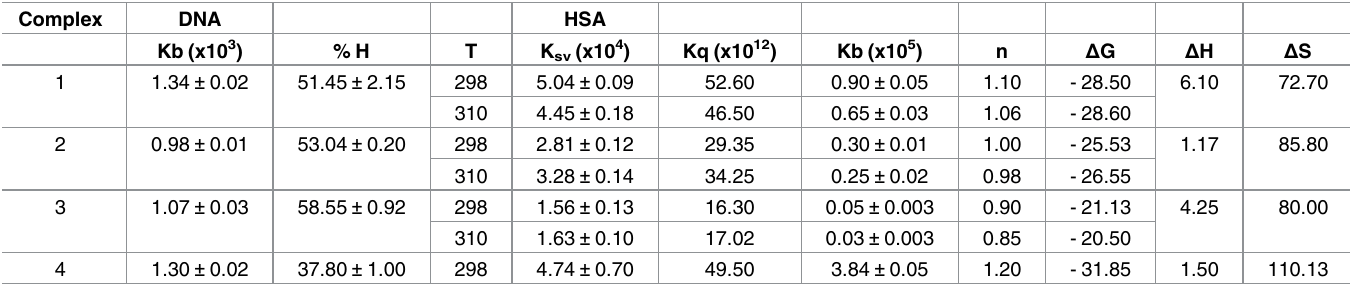
Table 2. Interactions with DNA and HSA. Bindingconstants for the interaction betweenRu(II) complexes (1–4) and calf thymus ct -DNA and stern-Volmer quenching constant (K sv , M -1 ), biomolecular quenching rate constant (Kq, M -1 s -1 ), bindingconstant (Kb, M -1 ), the number of bindingsites (n), Δ G(KJ.mol -1 ), Δ H (KJ.mol -1 ) and Δ S (J.mol -1 K) values for the complex-HSA system at different